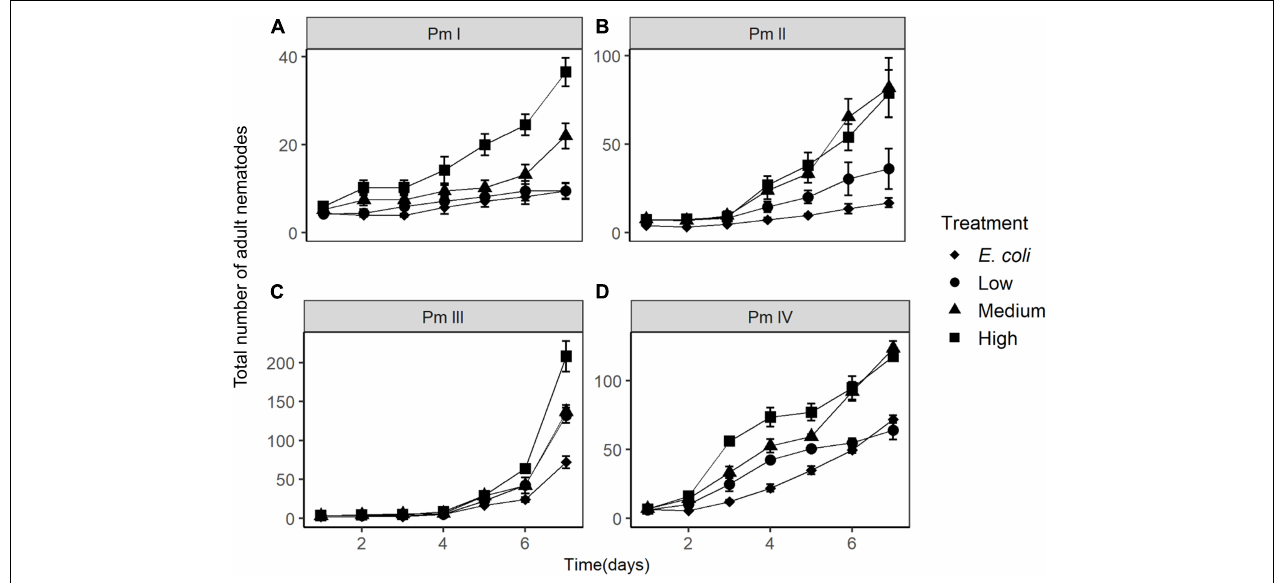
FIGURE 6 | Total number of adult nematodes over time (mean ± SE) in different food treatments ( E. coli , low diversity, medium diversity, and high diversity) for the four cryptic species of L. marina : (A) Pm I, (B) Pm II, (C) Pm III, and (D) Pm IV ( n = 4). Note the different y-axis scales in the panels.